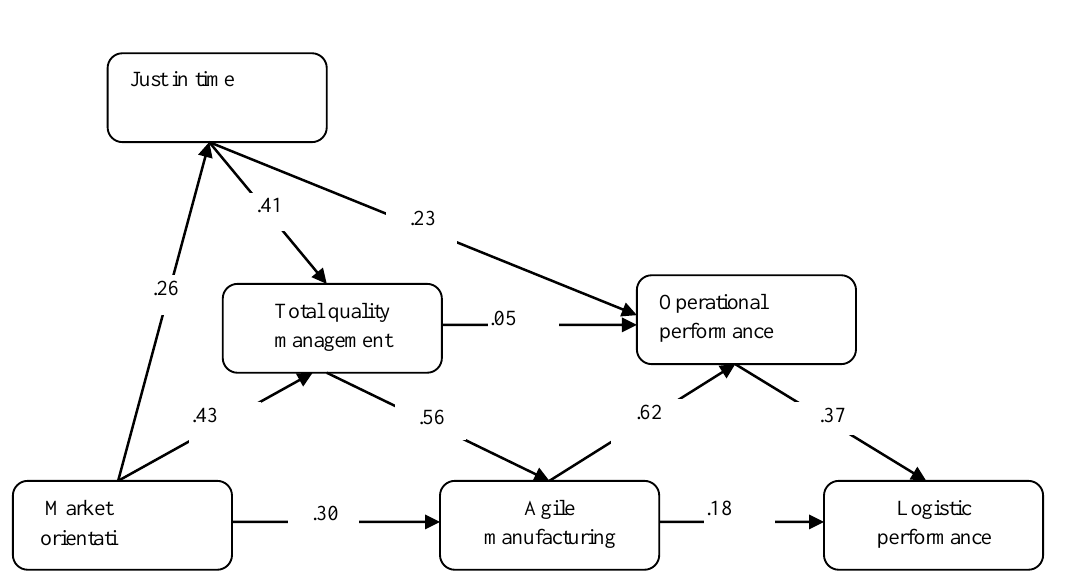
Fig 2. Path coefficients in the internal model of Smart